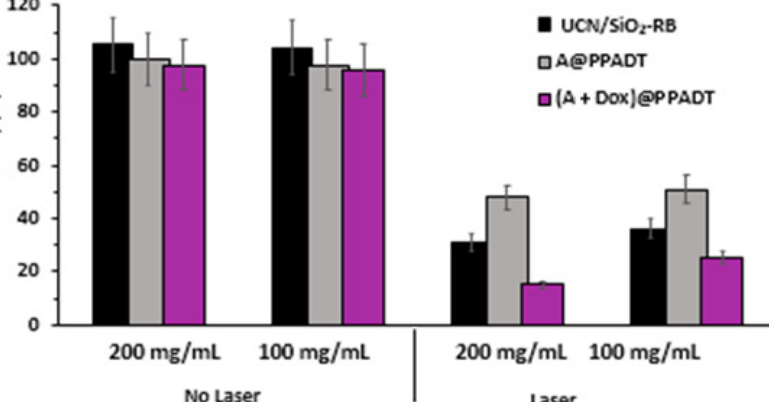
23 of 60 Figure 22. Preparation of polyglycerol MSNs with adsorbed fluorescein isothiocyanate (FITC) and RB. Adapted from Liu et al. [53]. After 10 min irradiation with a two-photon laser (100 W xenon lamp) of HeLa cells incubated for 4 h with FITC-PGSN-RB (0.5 mg/mL), cell viability decreased to 30%. Zhou et al. [54] synthesized NaYF 4 :Yb, Er (Y:Yb:Er = 78:20:2) as UCNPs, surrounded by a silica shell (SiO 2 ) covalently coupled to RB, on which poly-(1,4-phenyleneacetone dimethylenethioketal) (PPADT) was self-assembled as a second outer shell contains the NPs and DOX. The size of UCN/SiO 2 -RB was 38.2 ± 3.6 nm without DOX and PPADT. 1 O 2 production was confirmed using ABDA. During NIR laser irradiation (980 nm, 1.0 W/cm 2 , 20 min), DOX release was induced, with 40% of the DOX being released after 12 h of irradiation of (A + DOX)@PPADT. The 1 O 2 production under NIR laser irradiation caused the biodegradation of the polymer and the release of DOX into the tumor. In vitro tests were performed on HeLa cells, and cell viability decreased to 25% and 15% for cells